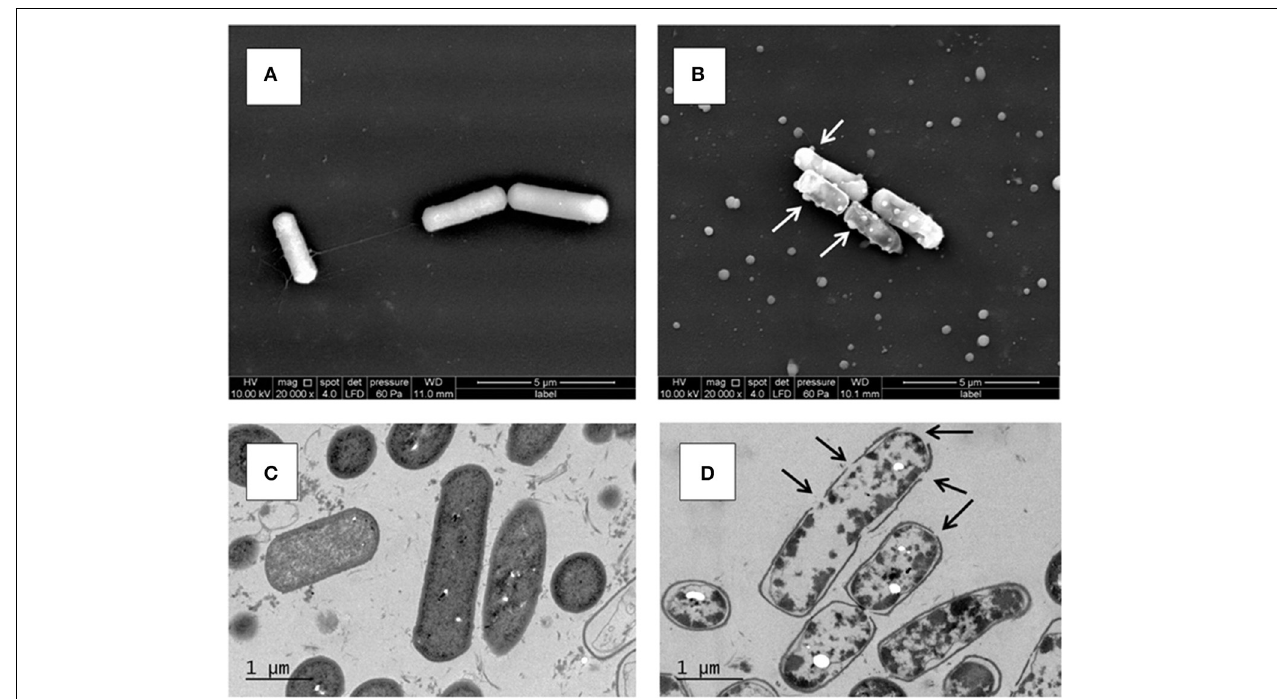
FIGURE 2 | Ultrastructure of B. weihenstephanensis KBAB4 cells grown at 25 ◦ C in BHI broth for 6 days. (A,B) SEM micrographs of cells from (A) the control culture (KC in Figure 1A ) or (B) the N 2 flushed culture (KN in Figure 1A ). White arrows indicate some of the cell wall-associated